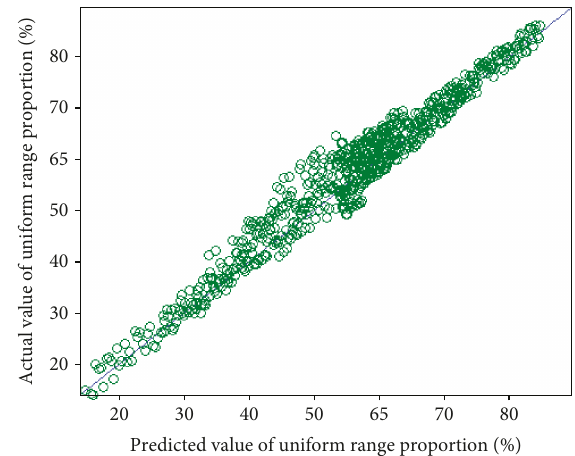
Figure 13: Scatter diagram of predicted values and actual values (tra ffi c congestion index).